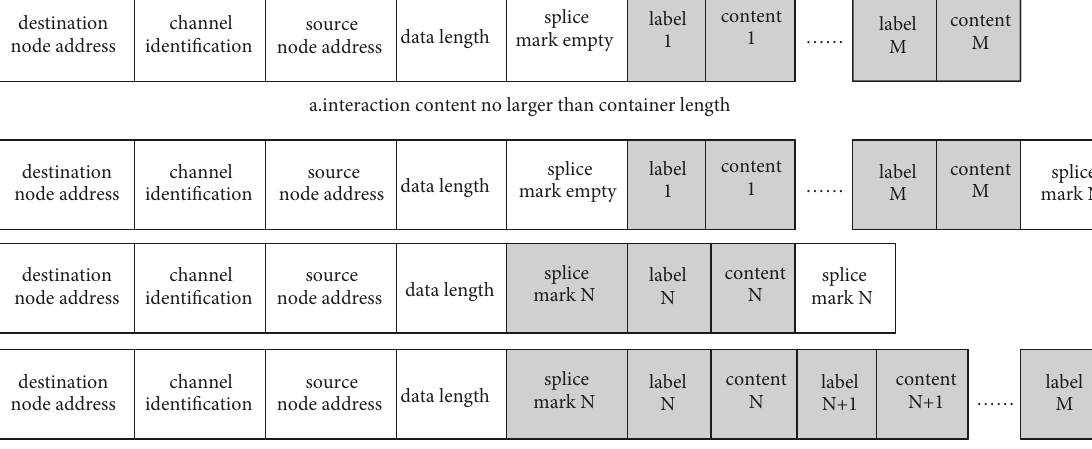
Figure 5: LoRa node packet